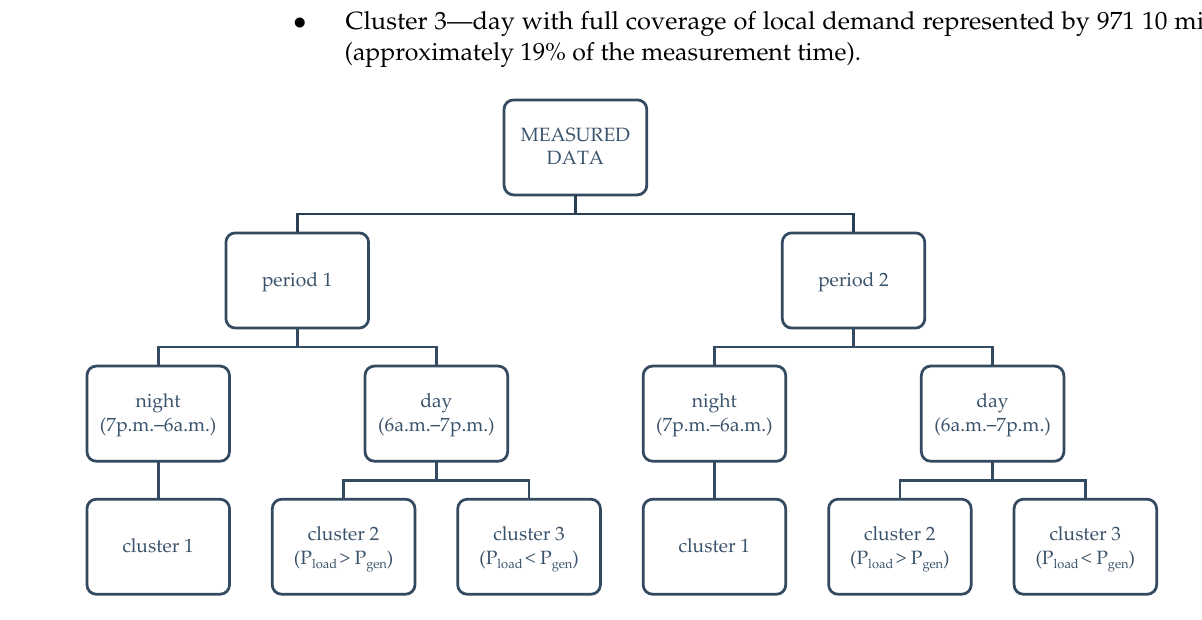
Figure 6. Diagram of the division of the measured data into individual periods and clusters.